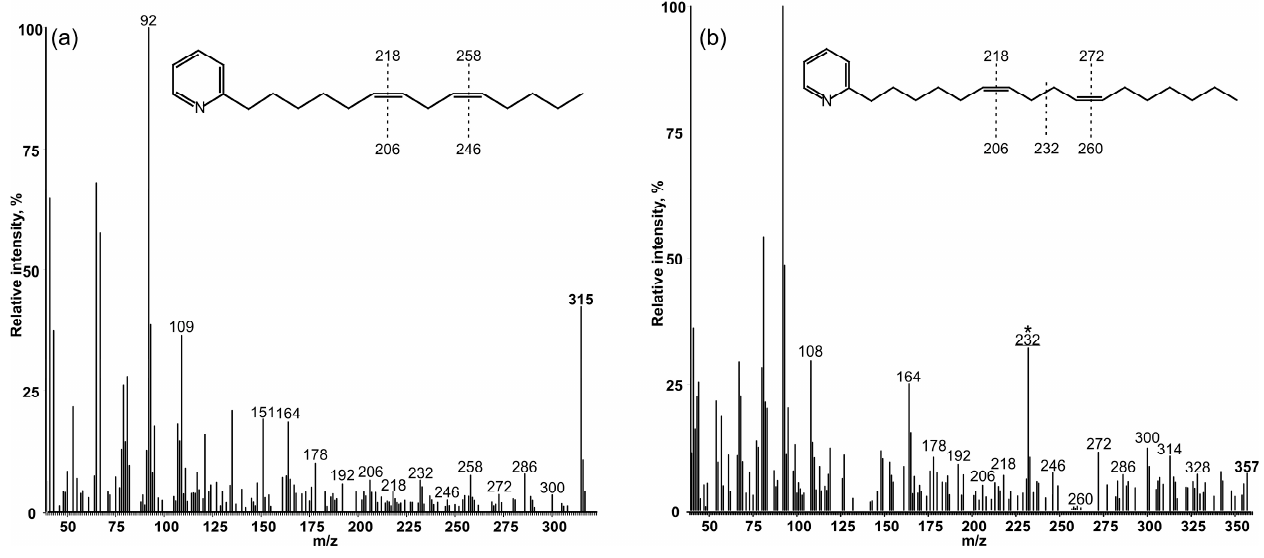
Figure 2. Mass-spectra 3-pyridylcarbinyl derivatives of ( a ) cis , cis -6,9-tetradecadienoic and ( b ) cis , cis - 6,10-heptadecadienoic acids, which were recorded after pre-concentration of FAMEs from the total lipids of Synechococcus cells that expressed the desD gene and were grown in the presence of the potassium salt of cis -17:1 Δ 10 .